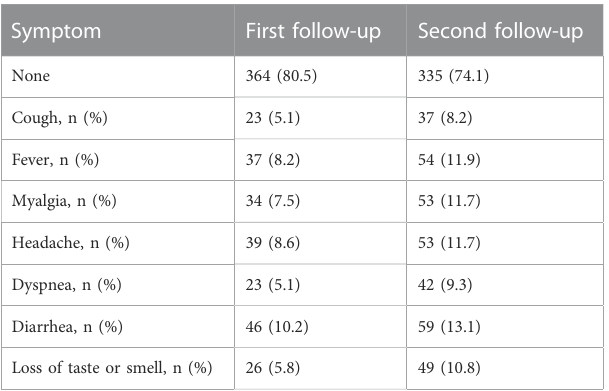
TABLE 3 Clinical symptoms of patients referred to MMT centers. (n = 452).